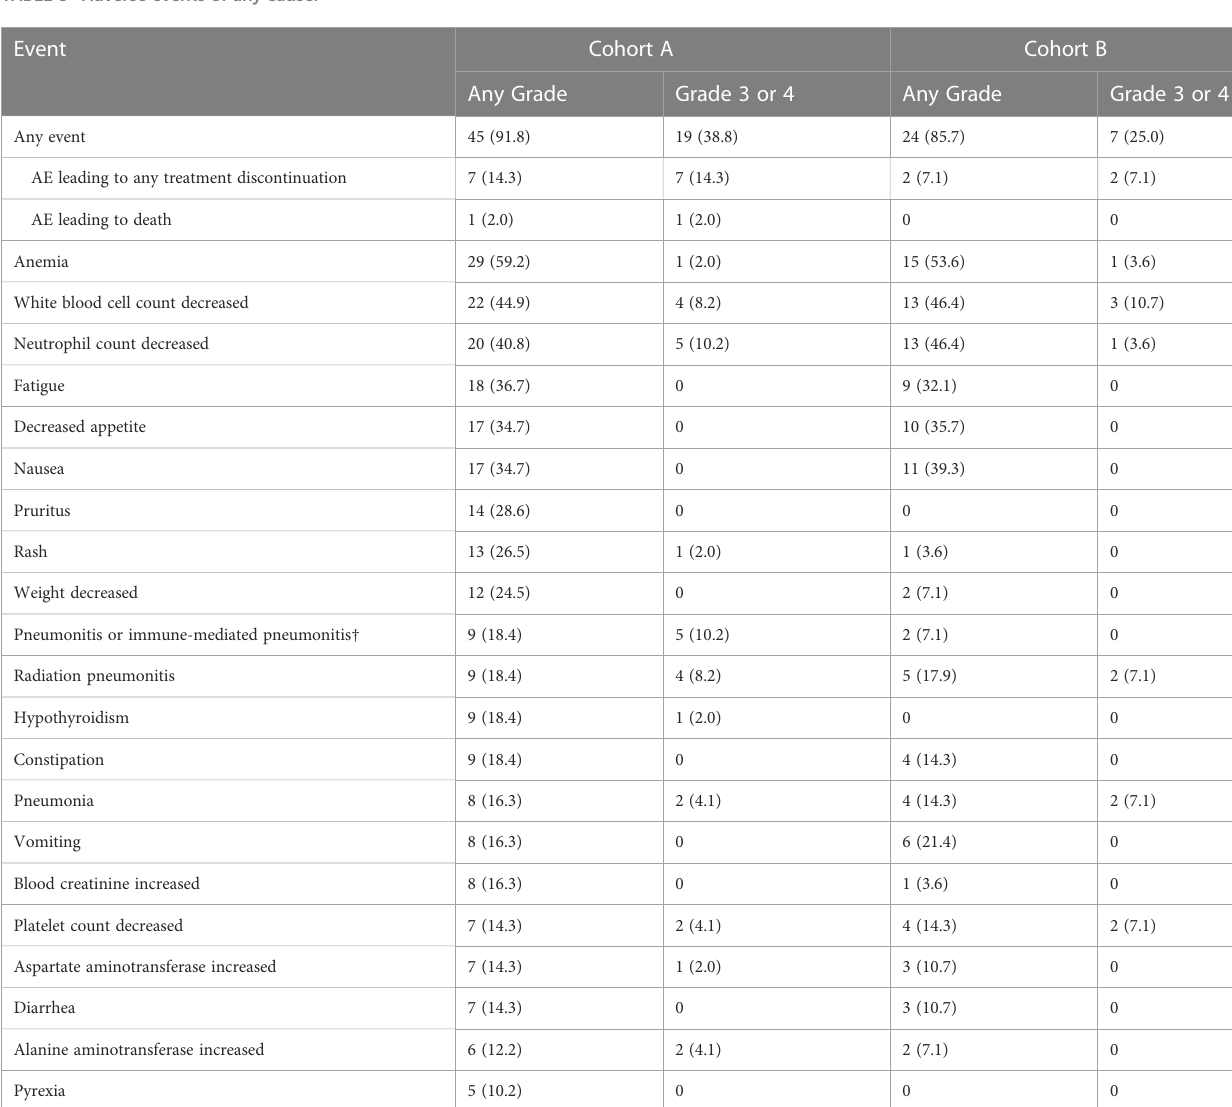
TABLE 3 Adverse events of any